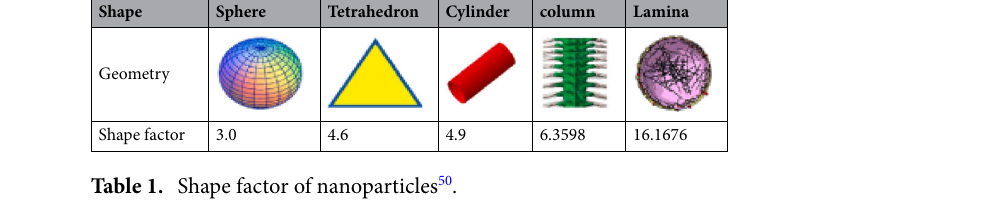
Table 1. Shape factor of nanoparticles 50 .